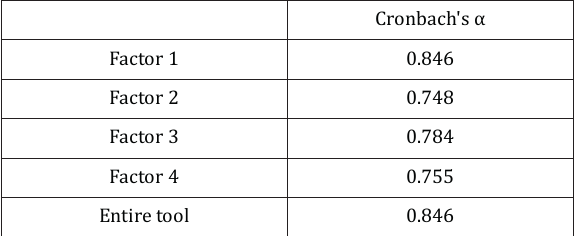
Table 2. The values of reliability coefficients (Cronbach's α) for the factors and the entire